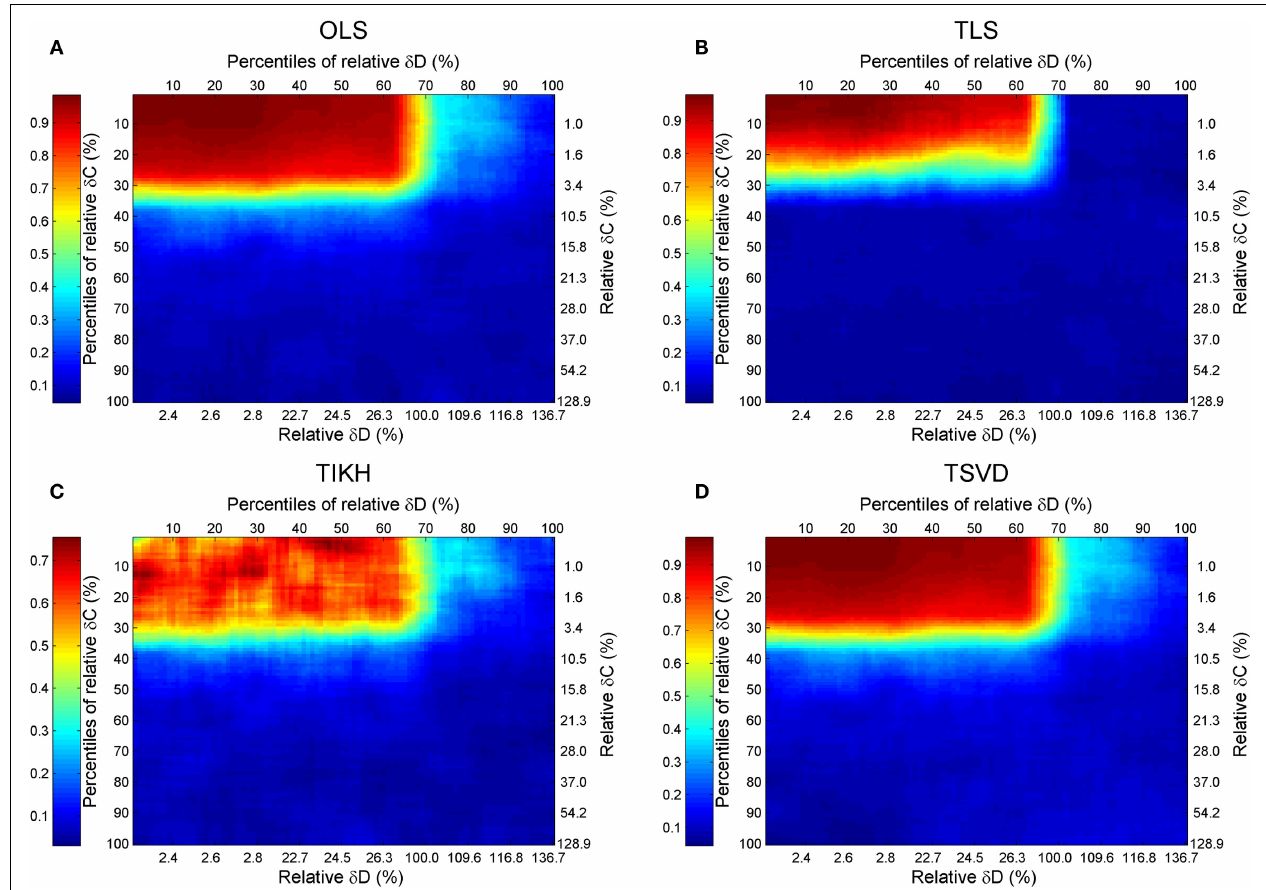
FIGURE 5 | The goodness of reverse Jacobian for the Sucrose PGM model under perturbations on both covariance and fluctuation matrices is represented as R 2 when regressed to the true Jacobian (vectorized, see Introduction) and shown by the heat map . The perturbations are measured by the percentile relative and relative changes of δ C and δ D over covariance and fluctuation matrix, respectively. The percentile relative change is calculated as percentiles of all relative changes δ C (or δ D ). The four reverse calculation methods are (A) OLS, ordinary least squares; (B) TLS, total least squares; (C) TIKH, Tikhonov regularization; and (D) TSVD, truncated singular value decomposition. The mean values of all 100 repeats for each level of perturbations are plotted.